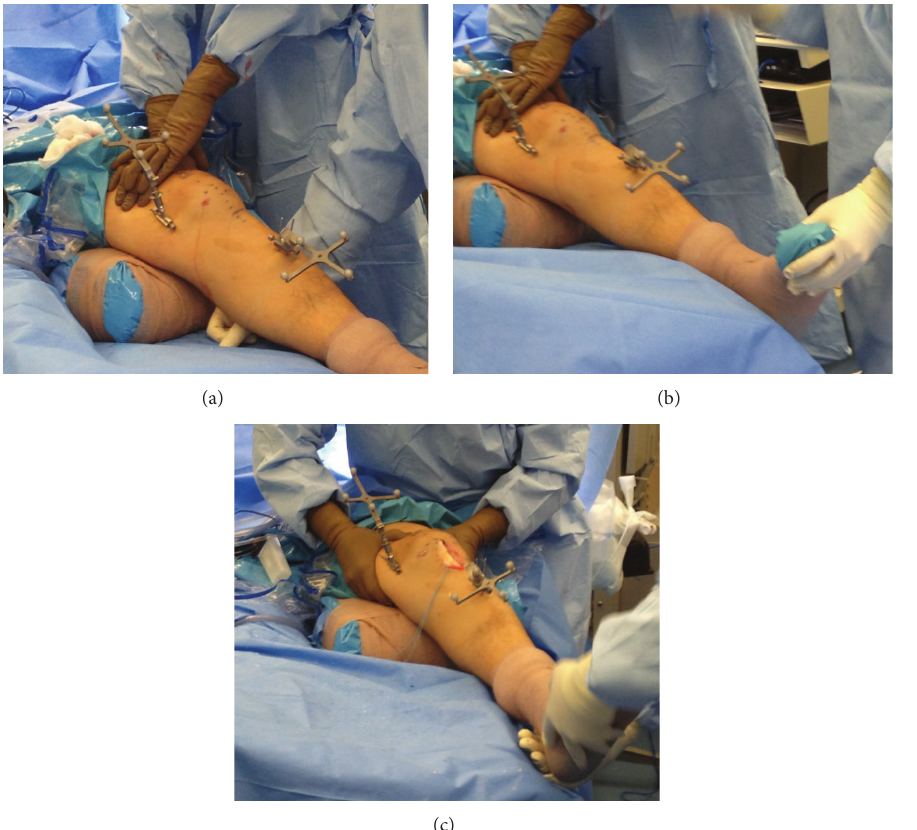
Figure 1: Intraoperative photographs showing positioning of the femoral and tibial navigation transmitters and demonstrating the stability testing maneuvers: anterior translation (a), internal rotation (b), and external rotation